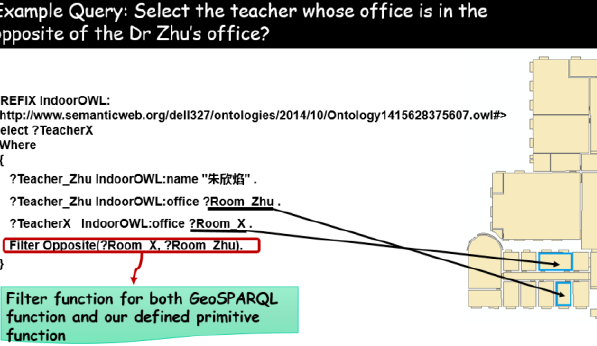
Figure 4. Example Query: Find teacher whose office is in the opposite of teacher Zhu’s office